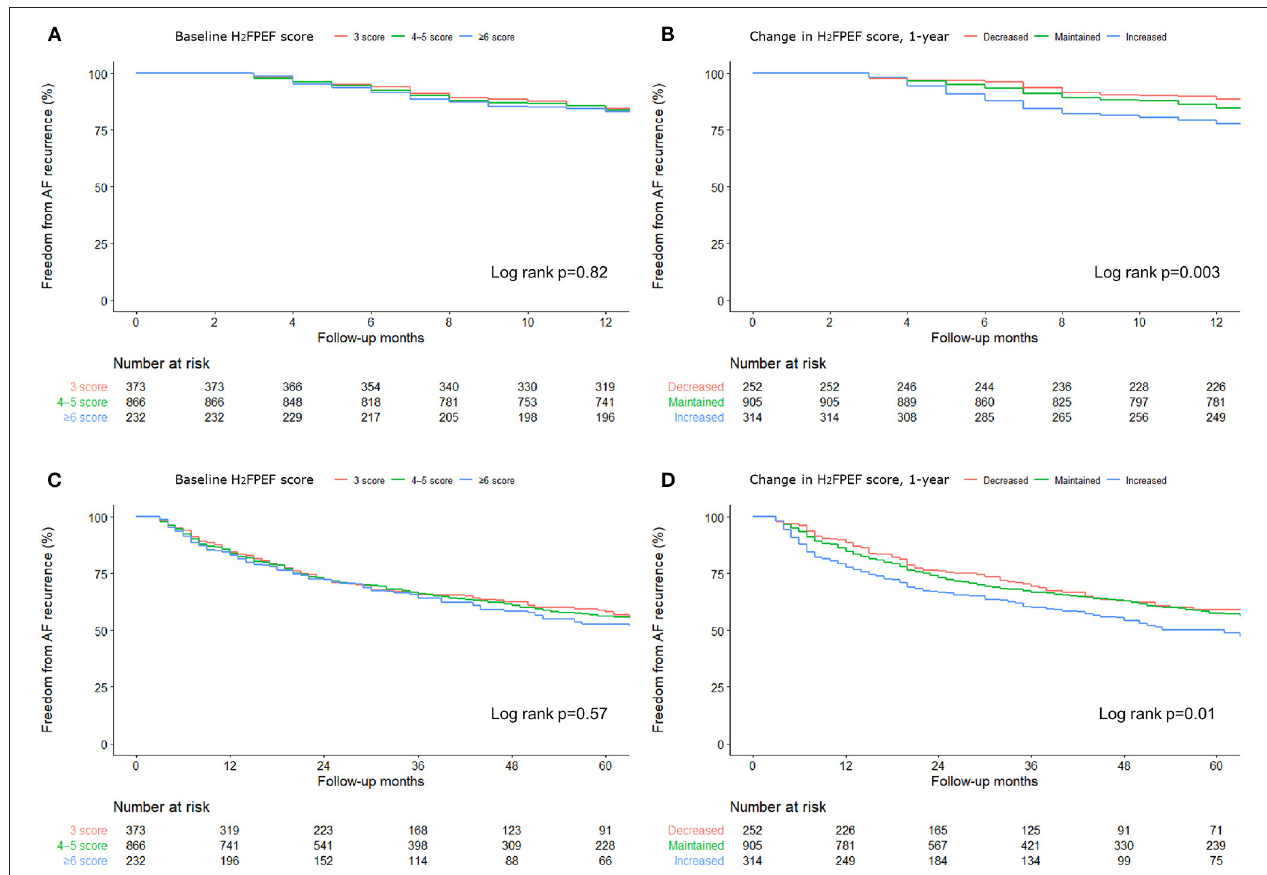
FIGURE 3 | Rate of the freedom from an AF recurrence over 1-year (A, B) and during the long-term (C, D) after the AFCA based on the baseline H 2 FPEF scores and changes in the 1-year H 2 FPEF